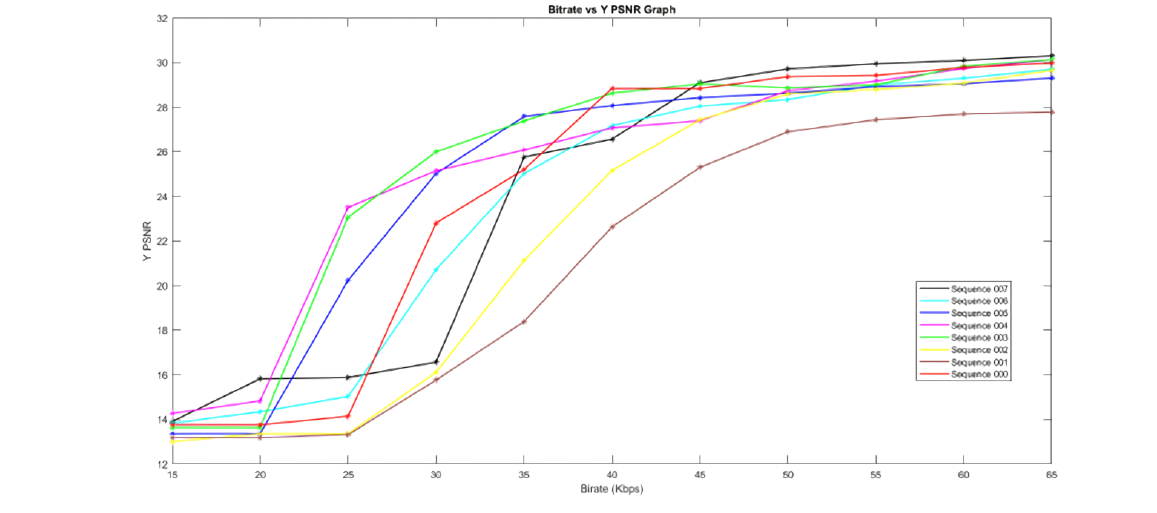
Figure 4. Bitrate vs. Y PSNR of video sequences.